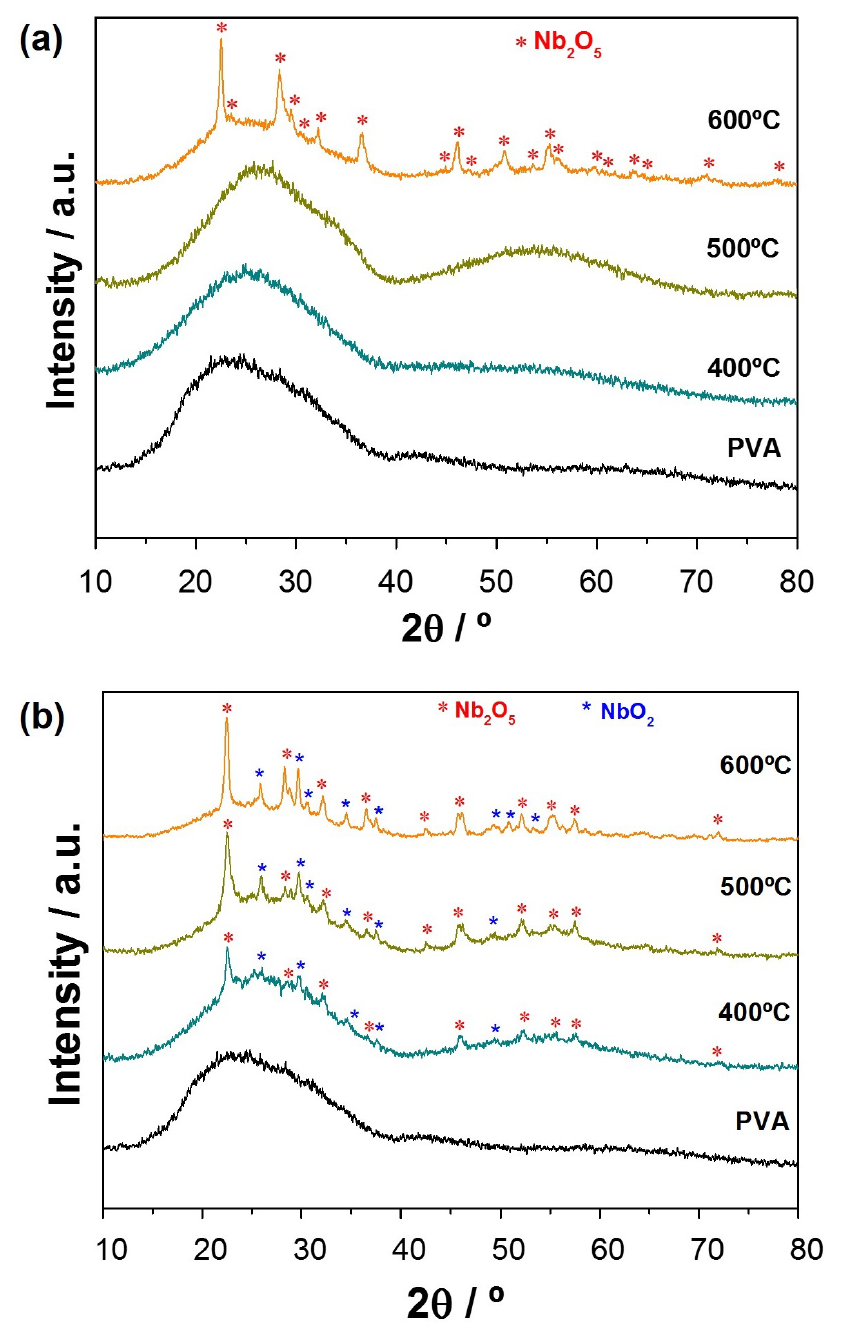
Figure 3. X-ray diffraction profiles of Nb 2 O 5 fibers after thermal treatments at 400 ◦ C, 500 ◦ C, and 600 ◦ C under a heating rate of ( a ) 1 ◦ C min − 1 and ( b ) 10 ◦ C min − 1